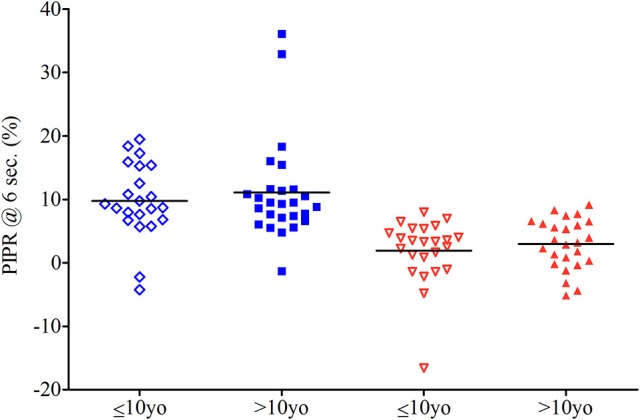
PIPR to blue light for 23 subjects in younger group and 26 subjects in older group and PIPR to red light for 24 in younger group and 26 in older group. Horizontal bars show the mean. Subjects in the younger group are shown in open diamond for the blue stimulation and open triangle for the red one. Those in the older group are respectively shown as closed squares and closed triangles.